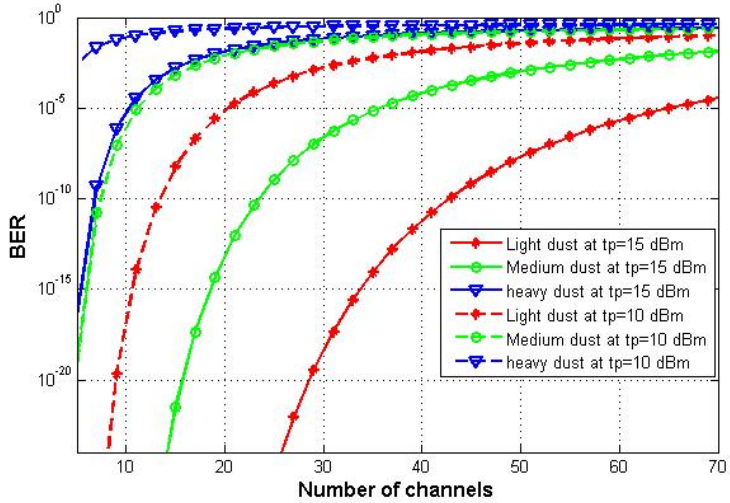
Figure 8. BER of FSO-PDM/PV-OCDMA system versus number of channels under dusty conditions.